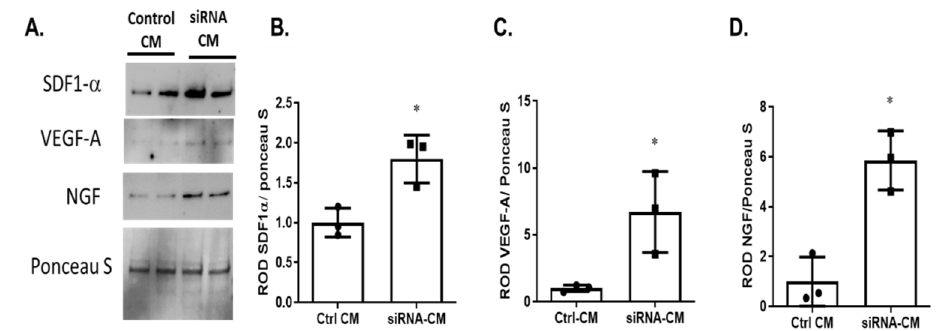
Figure 4. Silencing p75 NTR expression improves MSCs-secretome. Representative micrograph of Western blotting ( A ) and statistical analysis ( B – D ) of GFP-MSCs CM showed 1.8-Fold increase in SDF-1-a, 6-Fold increase in VEGF-A and 5.8-Fold increase in NGF, upon silencing the expression of p75 NTR (* p < 0.05, n = 3. Significance detected by unpaired student T-test).